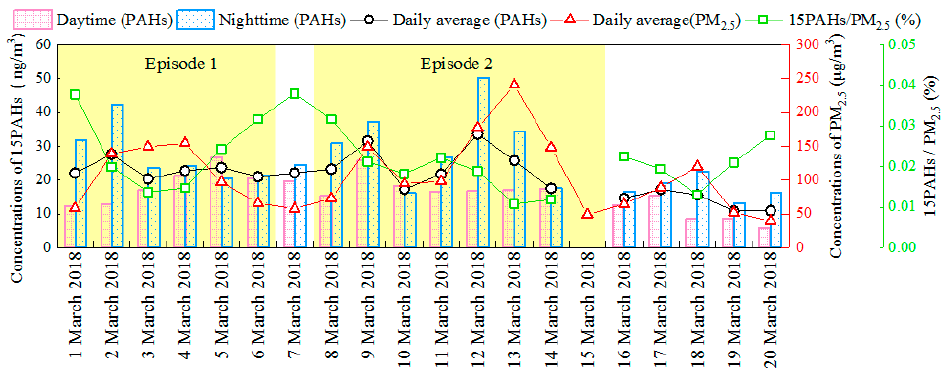
Figure 7. Daily and diurnal variation of mass concentrations of 15 PAHs in the study area during the monitoring period.